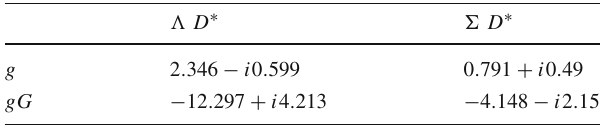
Table3 Valuesof g and gG forthedifferentchannelsfortheresonance − ) (cid:2) 0 ( 2815 )( 3 c 2